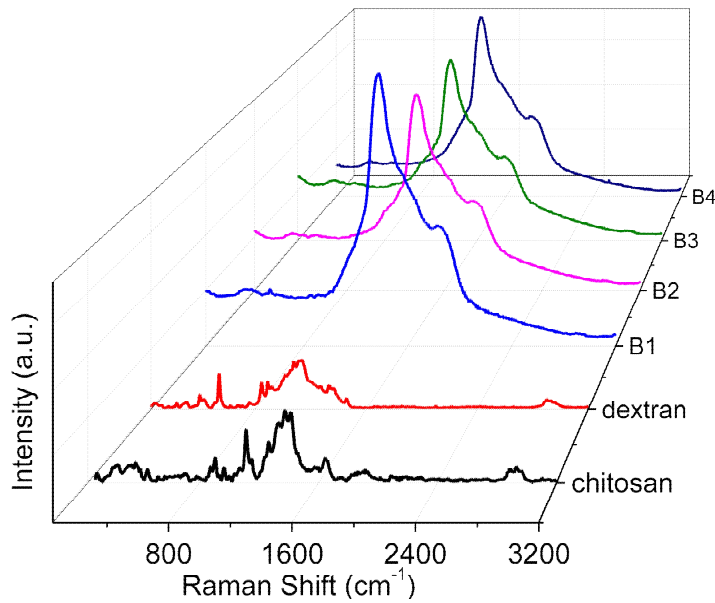
Figure 5. Raman spectra of chitosan, dextran, and their nanocomposites (B1, B2, B3, and B4).